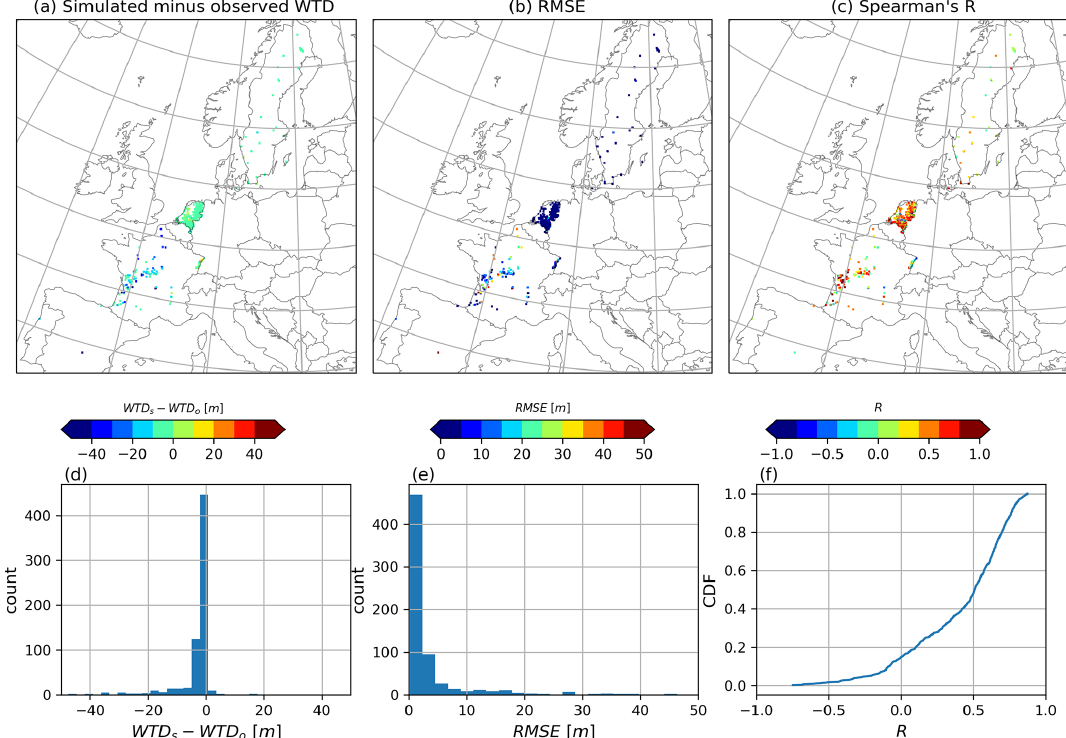
Figure 9. (a) Difference in observed and ParFlow-CLM-simulated WTD at filtered locations ( N = 720), (b) RMSE values at filtered locations and (c) Spearman correlation ( R ) values at selected locations. Histogram plots show the distribution of (d) simulated minus observed WTD and (e) RMSE values. (f) Cumulative distribution function (CDF) of Spearman correlation of ParFlow-CLM with observed WTD